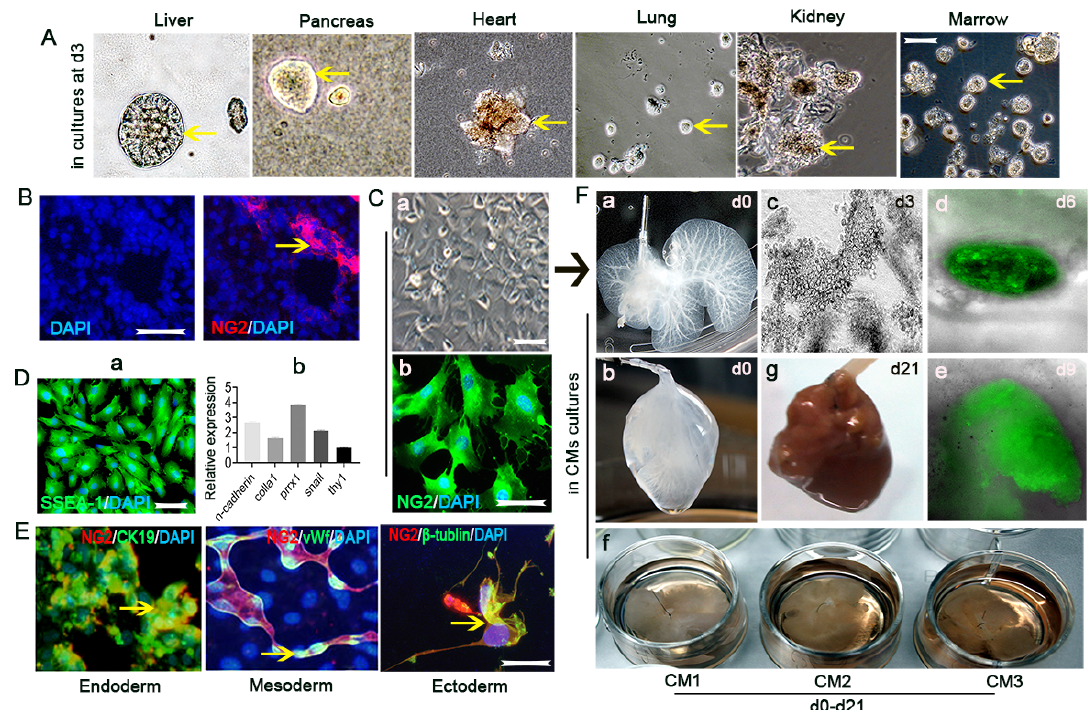
Figure 2. The novel method of “Percoll − Plate − Wait procedure” for NG2/CSPG4-expressing cell isolation from multiple adult mouse solid organs. ( A ) NG2/CSPG4-expressing cells were isolated from the adult liver, pancreas, heart, lungs, kidneys, or bone marrow and cultured as spheres (arrows). Scale bar = 100 µ m. ( B ) Hepatic NG2/CSPG4-expressing cells (red, denoted with an arrow) are located in the portal perivascular area (denoted with a box). Scale bar = 100 µ m. ( Ca , b ) Immunostained